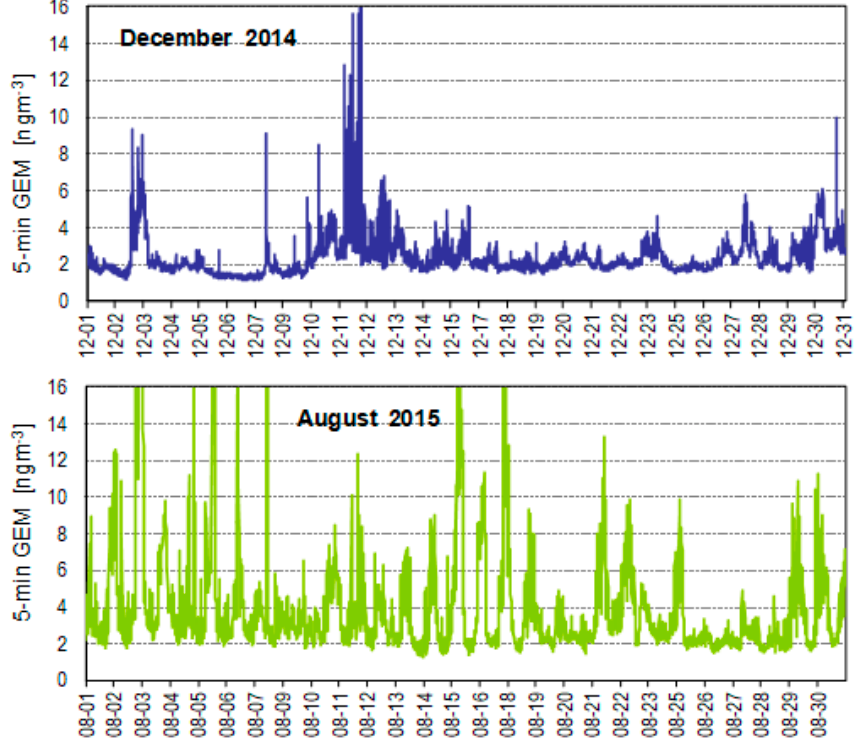
Figure 4. The concentrations of 5min GEM in December 2014 and August 2015 at the urban site in Zabrze (no diurnal pattern in winter and clear periodicity in summer with nocturnal maximum). At the rural background station in Z ł oty Potok, a higher mean TGM concentration (by 12%) was obtained in the winter season, which is in line with the literature. According to [36], the predominant seasonal TGM/GEM trend at rural sites is the winter-to-early-spring maximum and summer minimum. Higher TGM concentrations in Z ł oty Potok in winter season were mainly driven by the anthropogenic mercury emissions for heating purposes (coal combustion throughout the region and local biomass burning) and limited mixing in the ground boundary layer, and to a lesser extent by poor GEM oxidation and less